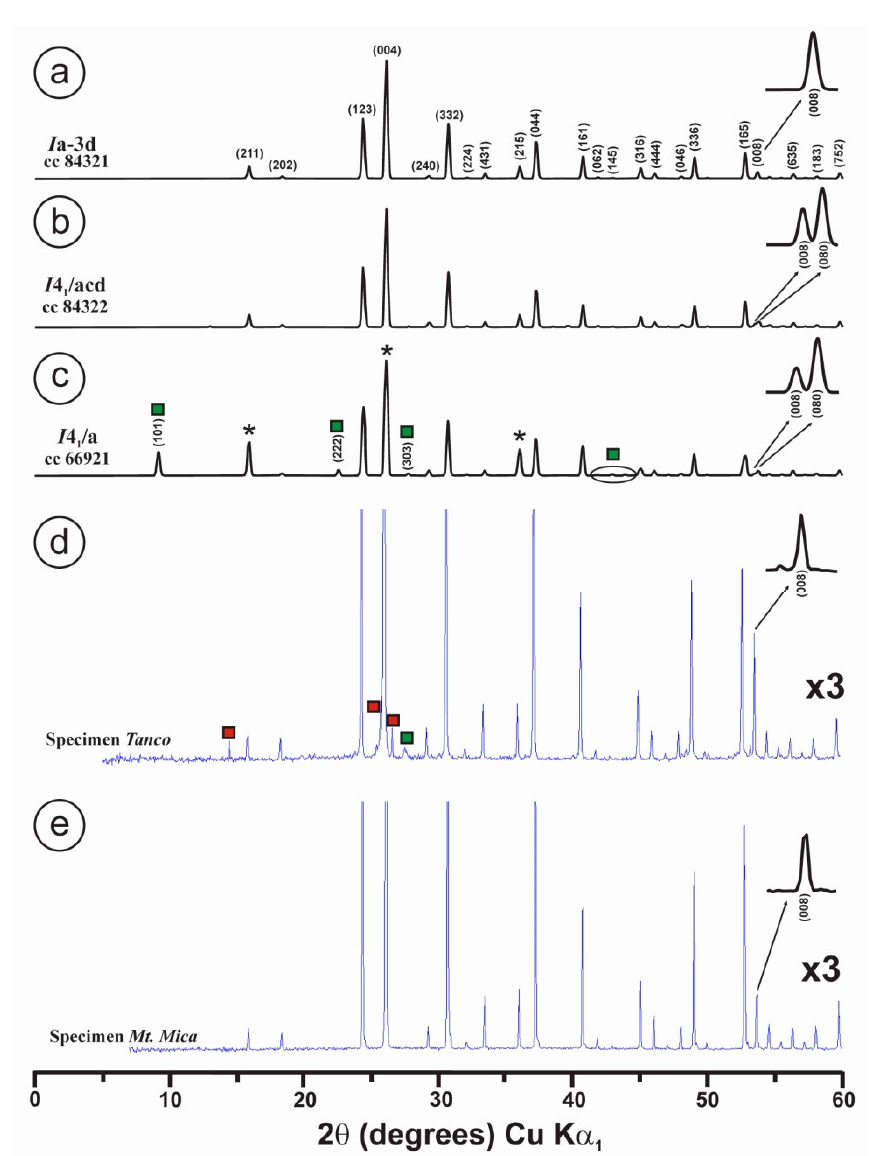
Figure 3. Calculated powder XRD patterns of pollucite up to 2 θ = 60°, from single-crystal measure- ments after the ICSD database, in comparison with experimental patterns in the two studied speci- mens. ( a ) The pattern from the Ia -3 d lattice model after file CC 84321 [9] with the main (hkl) peaks. ( b ) The pattern from the I 4 1 / acd lattice model after file CC 84322 [9] showing the peak splitting of the (008) cubic structure into (008) + (080) peaks of the tetragonal structure. ( c ) The pattern from the I 4 1 / a lattice model after file CC 66921 [7] to show some additional changes to peak splitting as some peak broadening mainly in peaks marked with an asterism, and also new peaks (green squares) including (101), (222) and (303) diffractions. These powder patterns were calculated for width pa- rameters as: u = 0.01, v = −0.01 and w = 0.02, Cu Kα 1 radiation at 1.5418 Å. ( d ) The powder pattern in specimen Tanco showing some peaks from impurities (red squares) and a signal similar to (303) of the model in ( c ) (green color) ( e ). ( d ) Powder pattern in specimen Mt. Mica showing only diffraction peaks from pollucite, consistent with the Ia -3 d model in ( a ). The patterns of ( d , e ) have been amplified by x3 to show the peaks with a low intensity. The details of the (008)-(080) peak splittings are for 2θ° values between 53° and 54° for the same width parameters, but the intensity of the (008) peaks in the two specimens have been modified to be comparable with that of the used models. Peaks that have a broadening with the phase transition are marked with *.